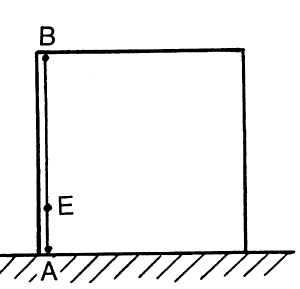
Fig. 4. Cantilevered plate, showing the impact excitation point, E, (behind) and the CSLDV scan line A-B. A zoom range of 100 Hz, centred on the mode at